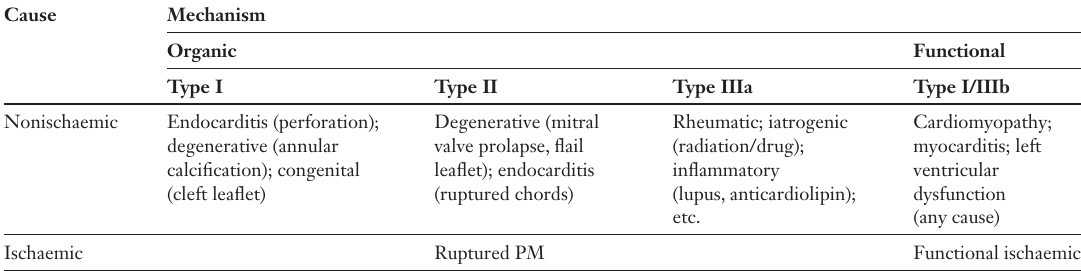
Causes and mechanisms of mitral